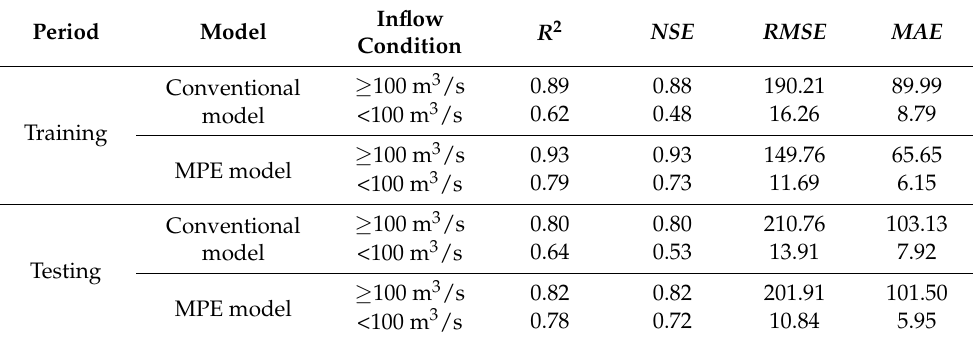
Figure 7. Scatter plots of predictions of both models using separate test data for ( a ) ≥ 100 m 3 /s and ( b ) <100 m 3 /s. Table 4. Comparison of performance of both models on separate test data.